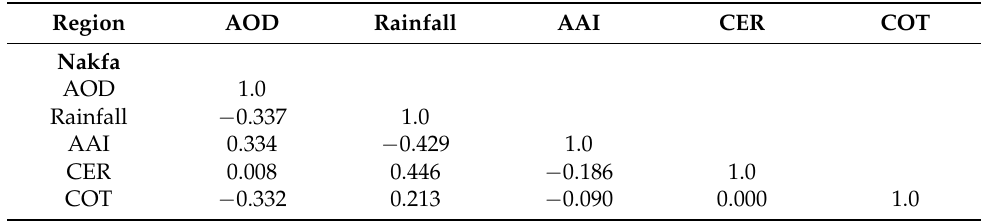
Table 6. The correlation coefficient values between AOD, rainfall, AAI, CER, and COT over Nakfa in July 2001 and